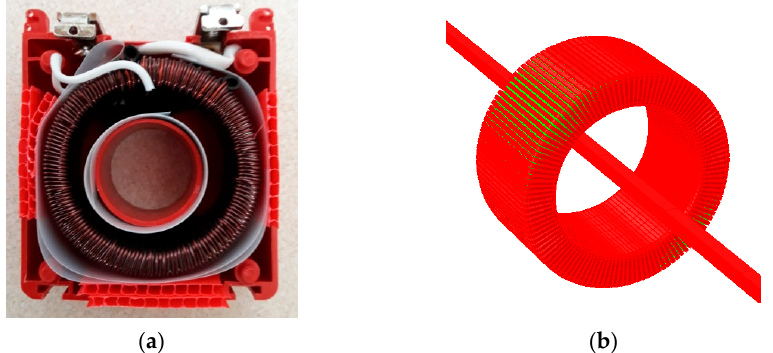
Figure 8. Toroidal current transformer type ELA 600 A/5 A class 0.2S ( a ) and its numerical model ( b ).